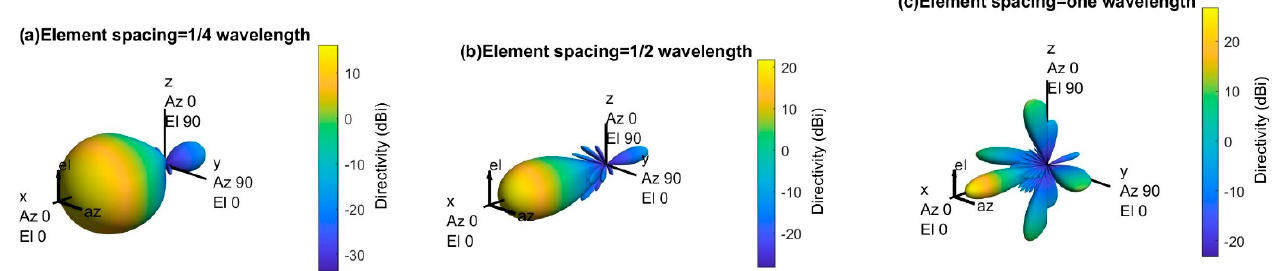
Figure 12. 3D radiation pattern of an 8-by-8 antenna array with different element spacing and reduced sidelobe power.